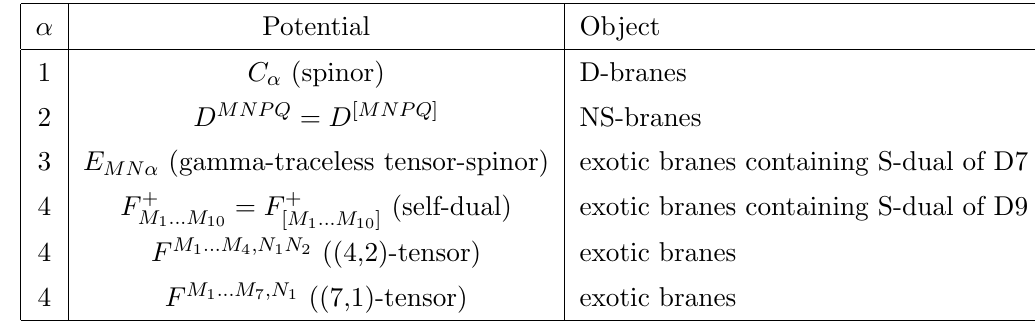
for (cid:11) = 1 ; : : : ; 4. BPS branes only couple s